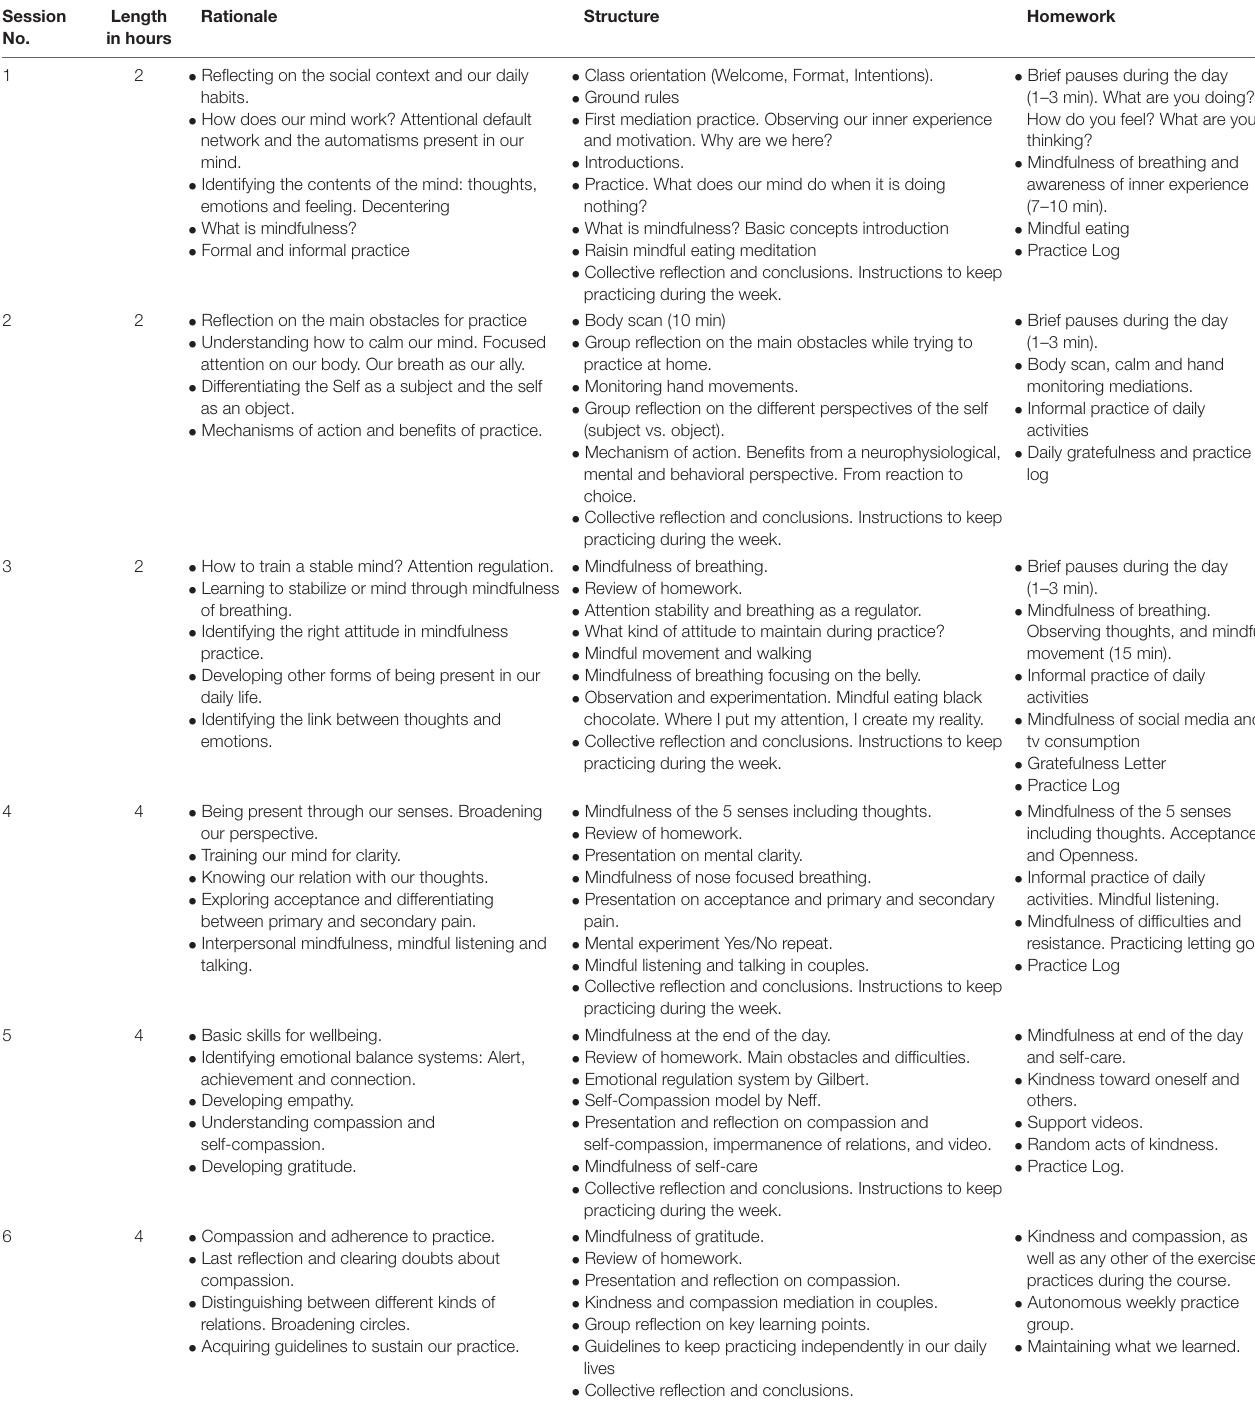
TABLE 2 | MSCBI intervention program specific session content and structure. Session